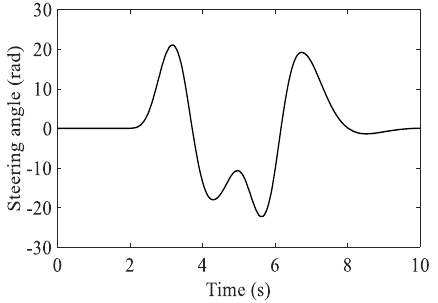
Figure 14. Front-wheel steering angle.